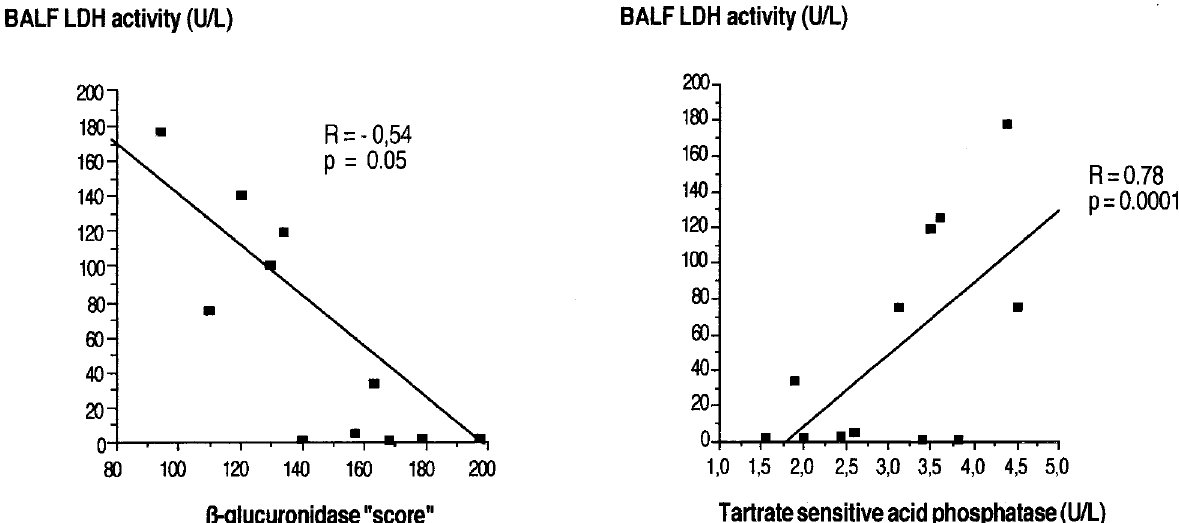
FIG. 6. Relationship between BALF LDH activity and lysosomal enzymes in acute EAA groups. Data were analysed by Pearson’s correlation